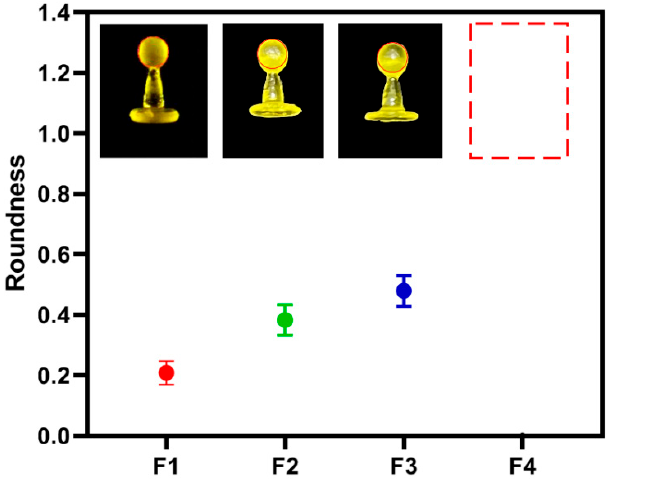
Figure 1. The roundness of printed pellets with different formulations and 0.10% tartrazine concen- tration.